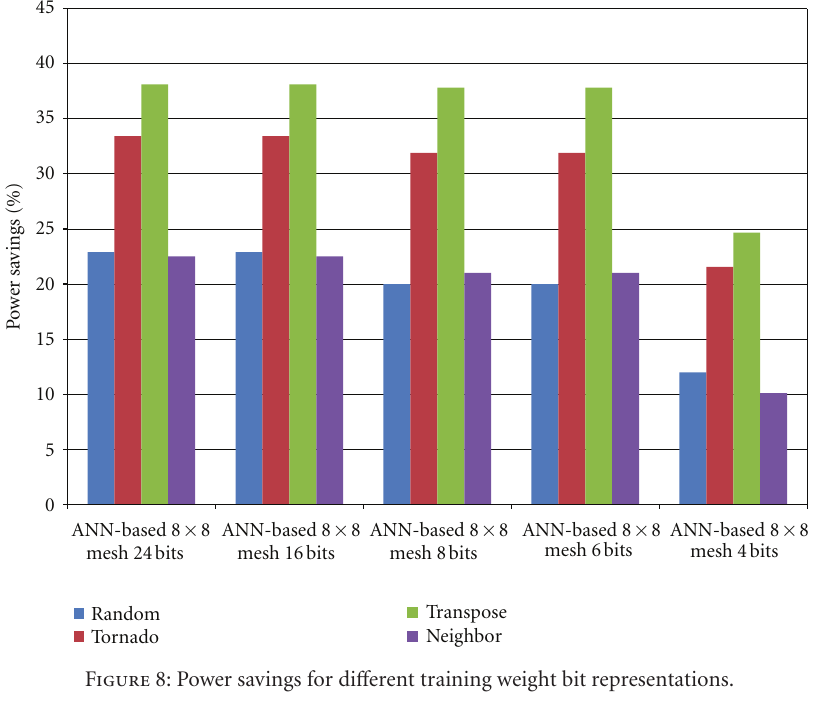
Figure 8: Power savings for di ff erent training weight bit representations.